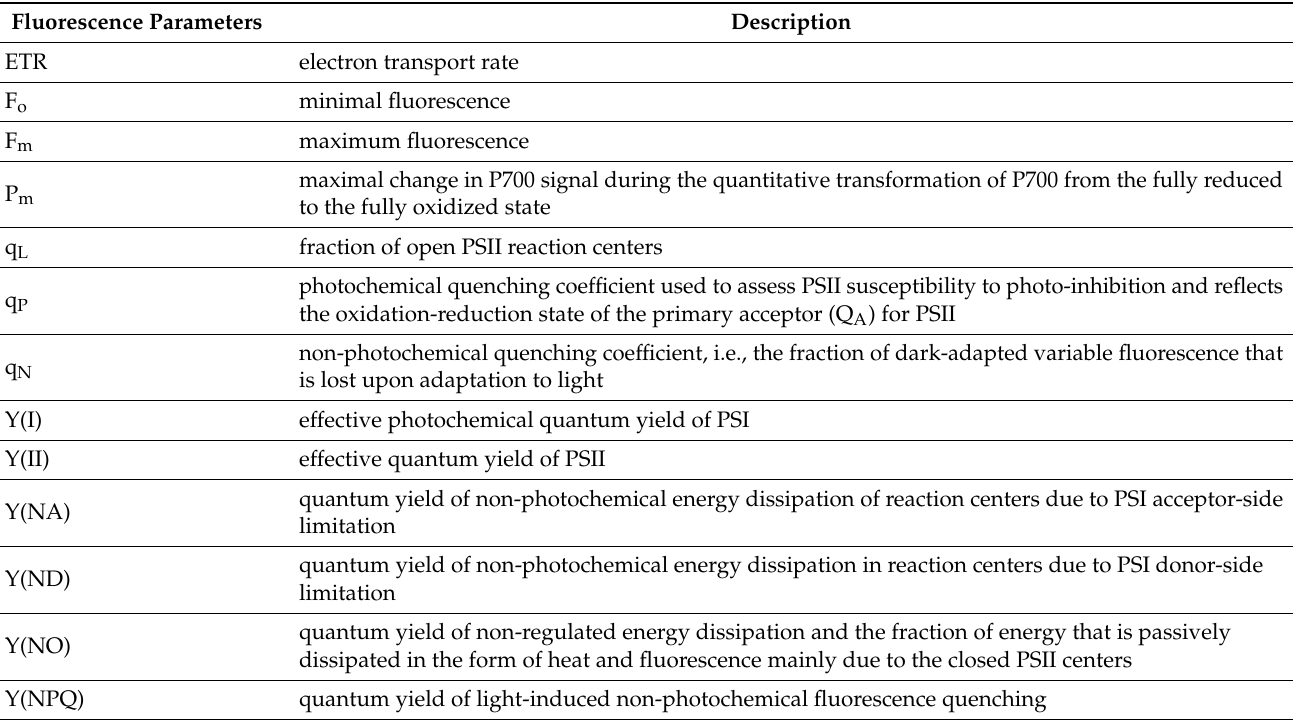
Table 1. Description of various Chlorophyll a fluorescence parameters